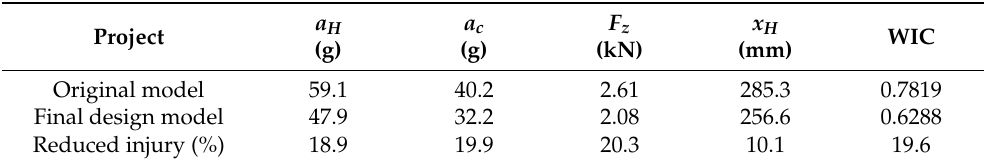
Table 3. Comparison of child dummy injury indices between the final design model and the original model.